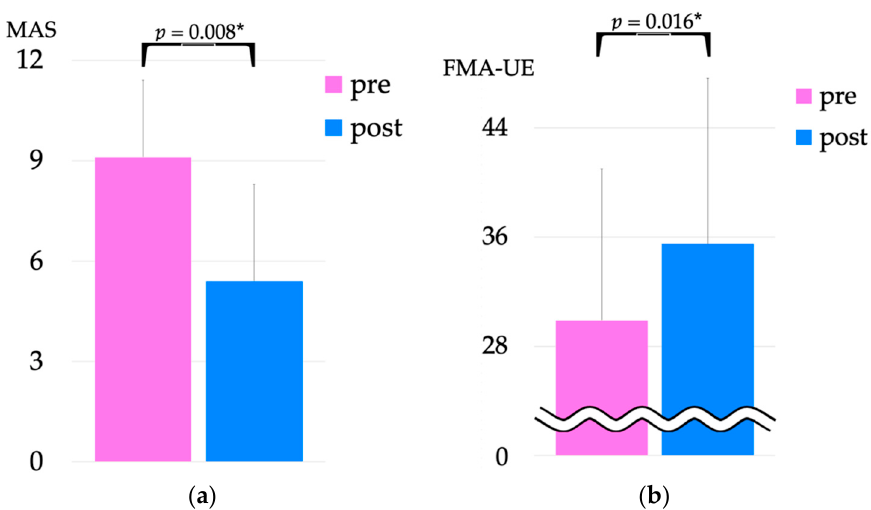
Figure 7. Comparison of MAS ( a ) and FMA ‐ UE ( b ) scores pre ‐ and post ‐ intervention. * p > 0.05. FMA ‐ UE, Fugl Meyer assessment upper extreme; MAS, modified Ashworth scale. Both MAS and FMA ‐ UE scores significantly improved post ‐ intervention.